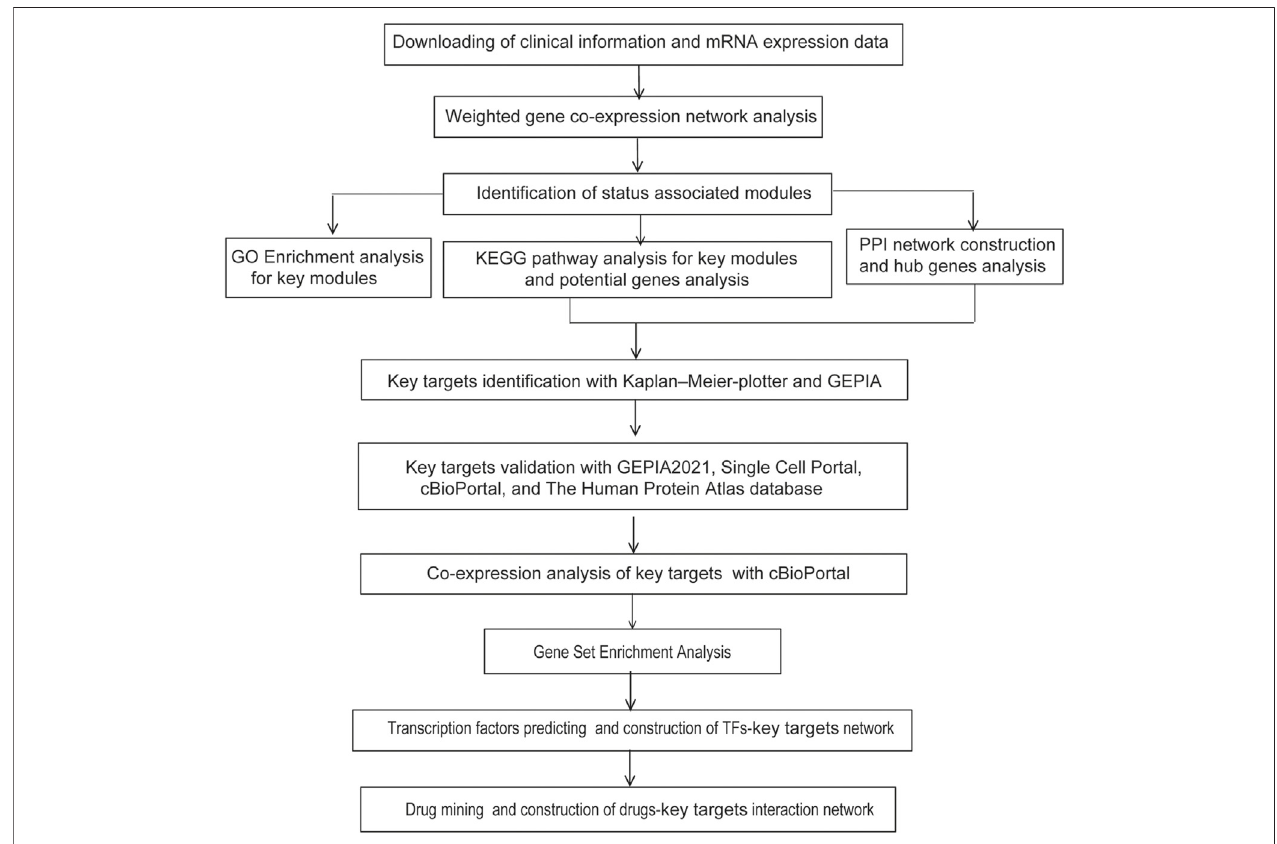
FIGURE 1 | Experimental design and work fl ow of this study.